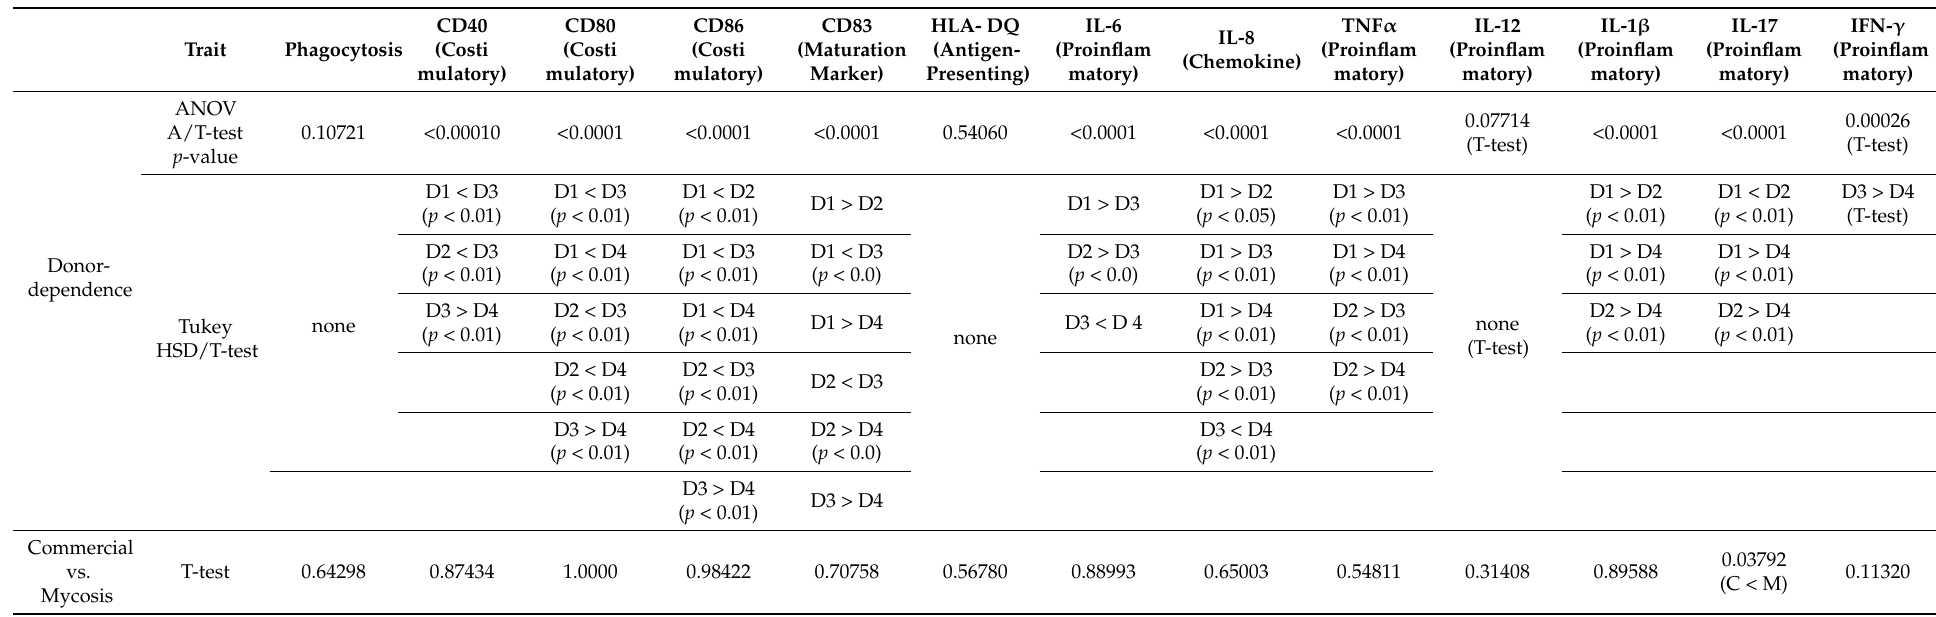
Table 3. Statistical comparison of isolate groups and donors for DC and T-cell activation, along with DC